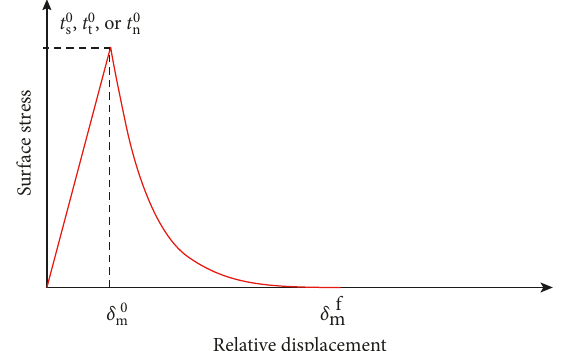
Figure 4: Schematic stress-strain behavior of masonry